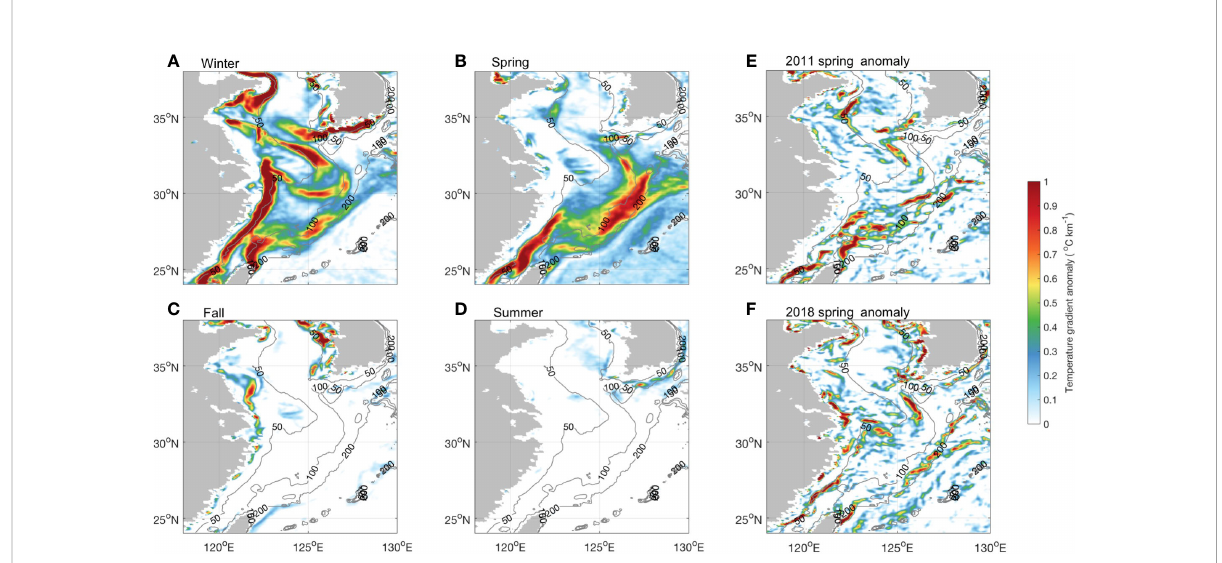
FIGURE 12 Seasonal anomalies of the temperature (SST) gradient, which are the differences between the mean SST gradient for each season and the annual mean SST gradient: (A) winter (December – February), (B) spring (March – May), (C) fall (September – November), and (D) summer (June – August). (E) 2011 spring SST gradient anomaly. (F) 2018 spring SST gradient anomaly. The gray contour lines in each map denote the 50-, 100-, and 200-m